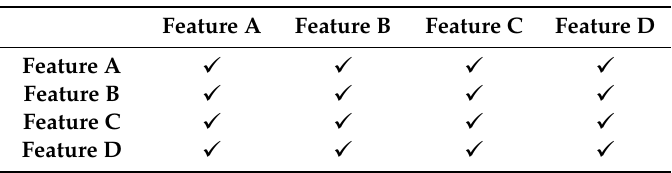
Table 1. Feature Matrix.